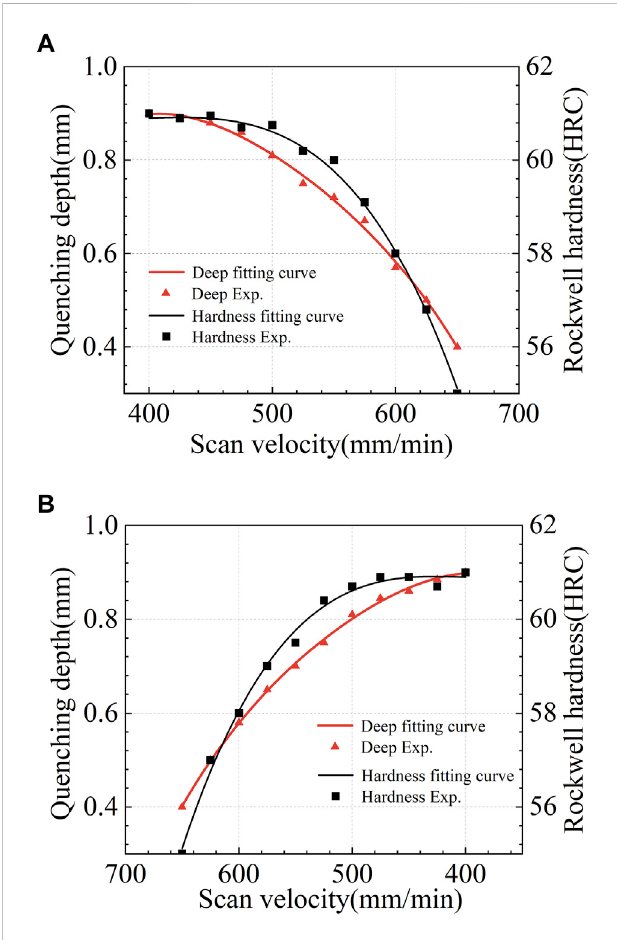
FIGURE 4 (A) Deceleration quenching results. (B) Accelerated quenching results. Results of variable quenching scanning